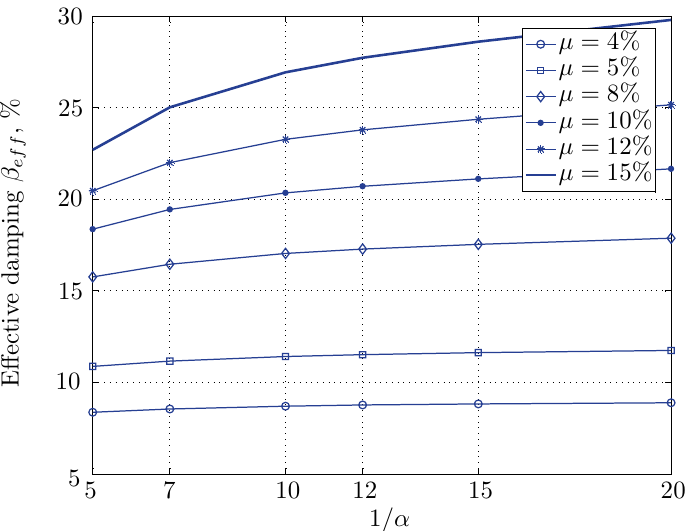
Figure 36. Effective damping for various isolation system parameters (Petrolia).